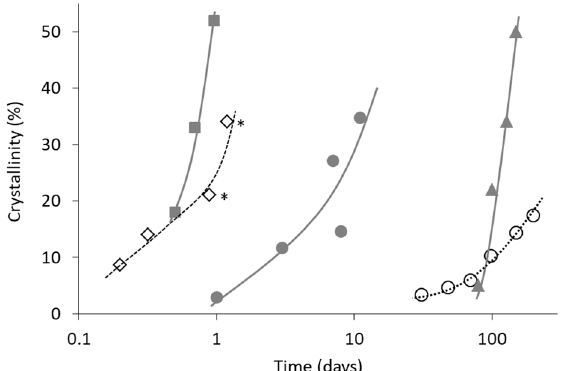
Figure 7. Isothermal crystallization of indomethacin glasses at 30 °C under dried condition. ( ■ ) Quenched and ground for 6 min. Crystallized to form γ [51]. ( ◇ ) Quenched and ground. Crystallized to form α except that symbols with asterisk involves small amount of form γ [54]. ( ● ) Quenched and cryoground. Crystallized to mixture of form α and γ (our data). ( ▲ ) Quenched. Crystallized to form γ [55]. ( ○ ) Quenched and stored in DSC pan (our data). Crystallized to form α which contains small amount of form γ .